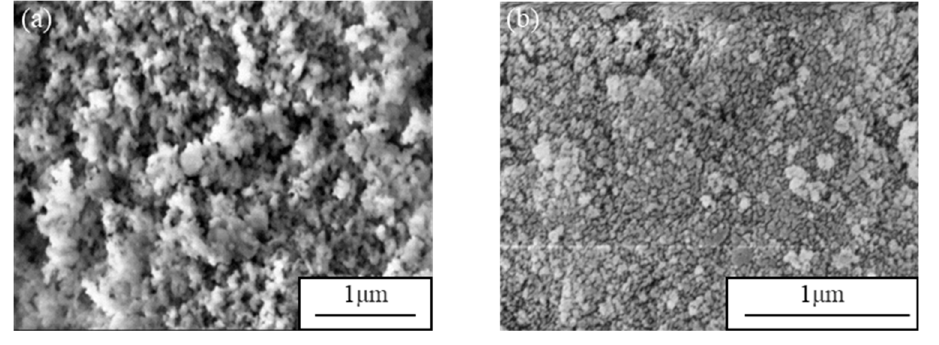
Figure 6. The influence of NH 3 •H 2 O on the microstructure of SiBCO aerogel. ( a ) n(NH 4 OH)/n(TEOS) = 0.02; ( b ) n(NH 4 OH)/n(TEOS) =